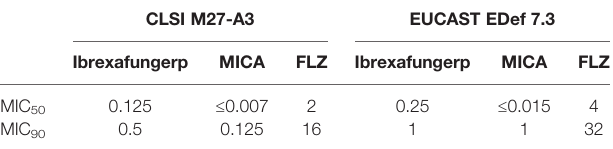
TABLE 3 | MIC values ( m g/ml) of ibrexafungerp and comparators against 31 C . glabrata isolates using two microdilution broth procedures, the clinical and Laboratory Standards Institute (CLSI) M27-A3 and EUCAST EDef 7.3 (Pfaller M., et al., 2012).